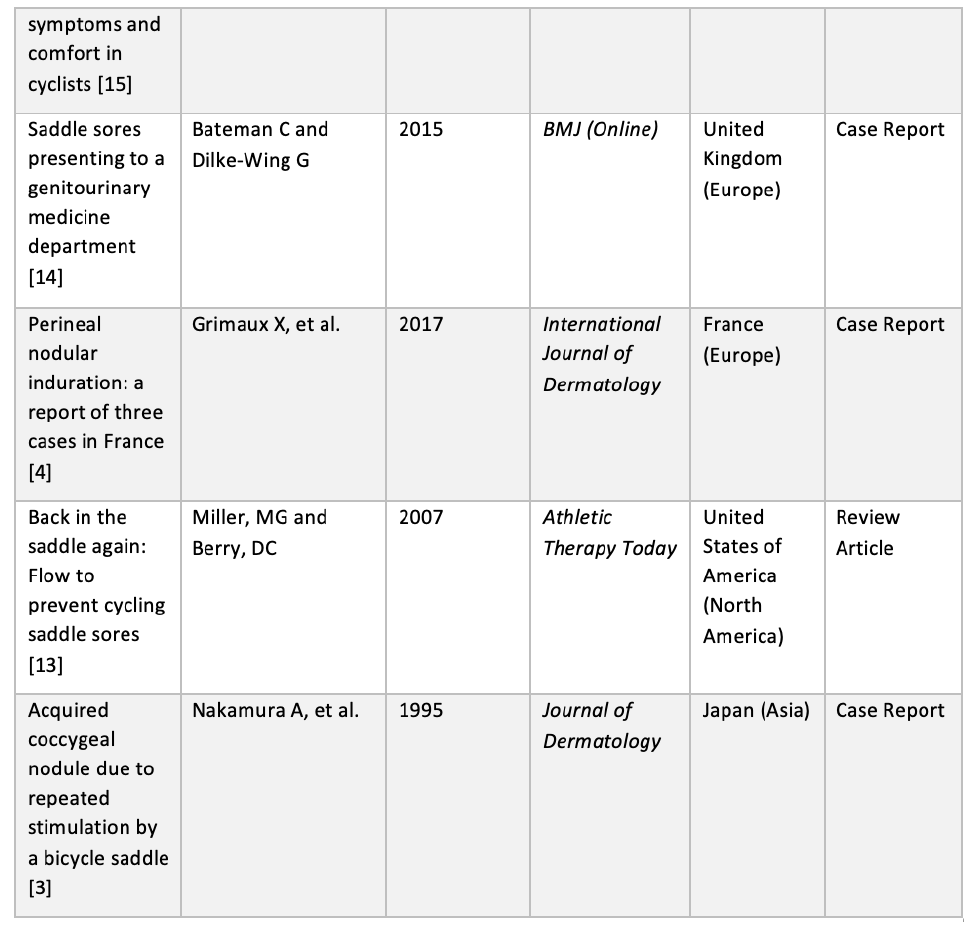
Figure 2. Table of included studies [1–5,9,10,13–22]. Table 1. Age profile of patients included in case studies. Note: all case study patients are